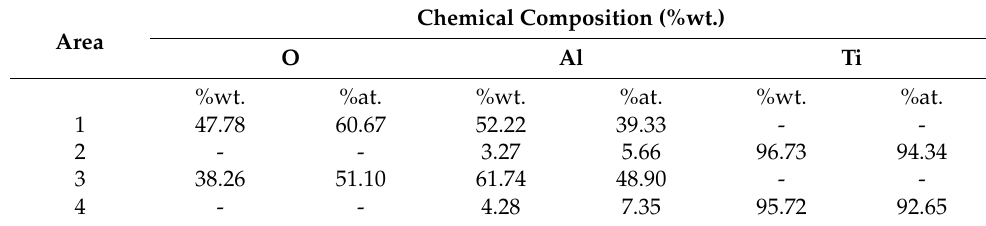
Figure 9. Maps of chemical element distribution on the sample surface. Table 4. Chemical composition of characteristic areas of the composites. Measurement areas are shown in Figure 9.